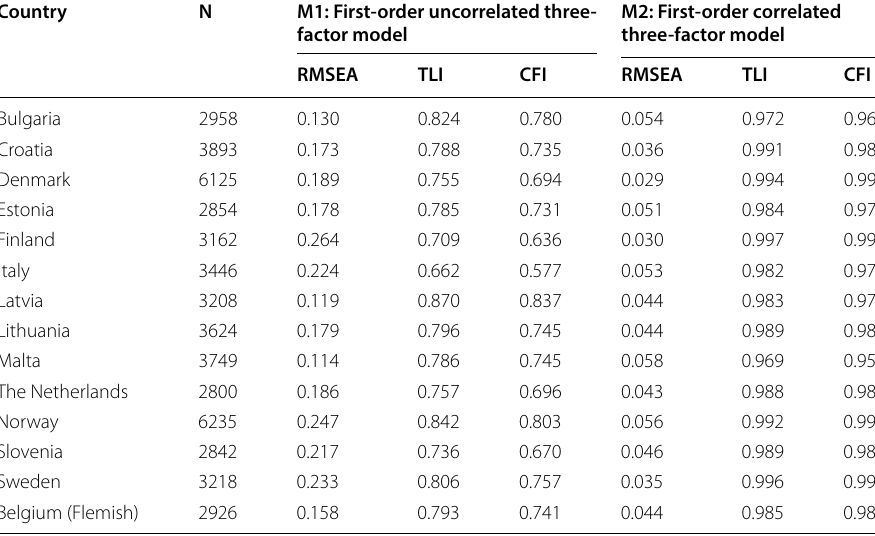
Country-specific models